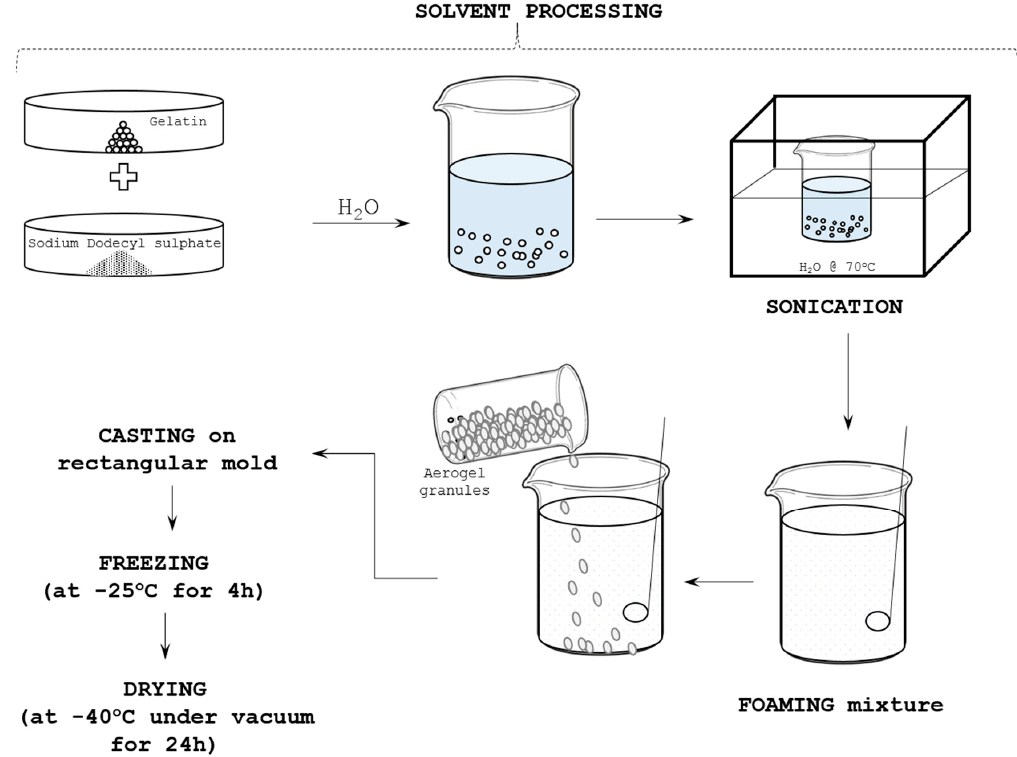
Figure 9. Schematic representation of silica aerogel composites synthesis procedure.